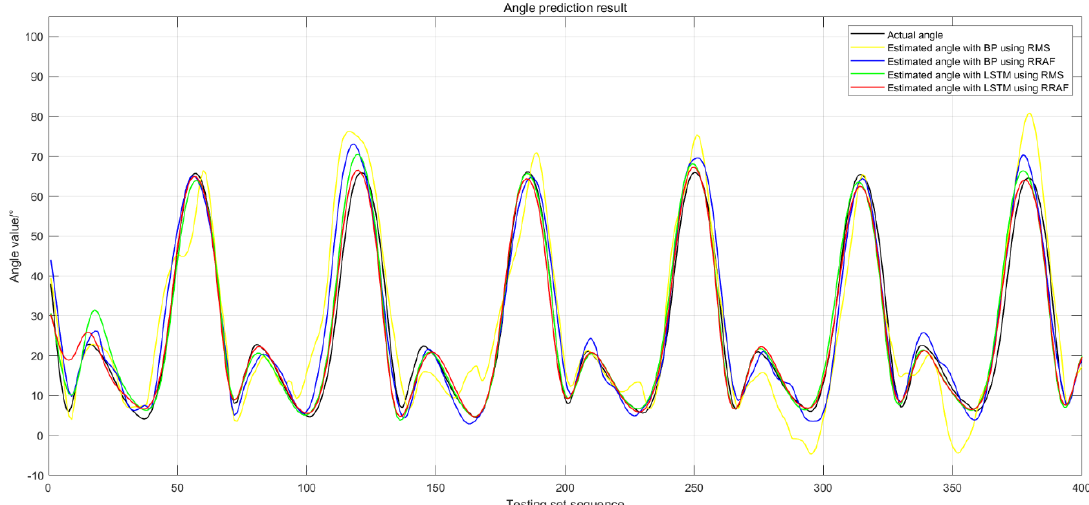
Figure 9. Knee angle estimation curves obtained with the four algorithms based on the data collected from subject 2 at a walking speed of 1.0 m / s. The black line represents the actual angle curve; the yellow, blue, green, and red lines represent the estimated angle with BPNN using RMS, BPNN using RRTAF, LSTM using RMS, and LSTM using RRTAF.